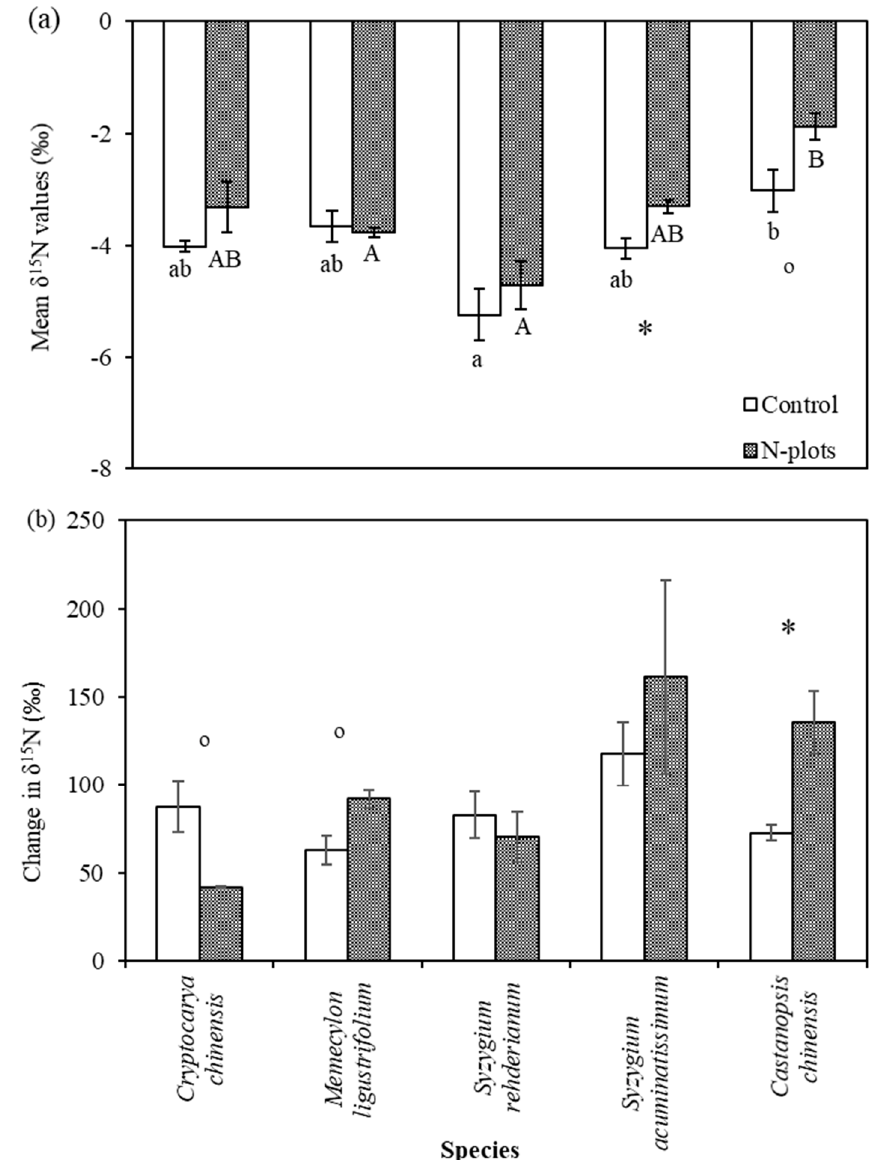
Figure 1. Leaf δ 15 N values of co-occurring dominant tree species in Dinghushan Biosphere Reserve (DHSBR): ( a ) natural δ 15 N abundance in control and N-plots; and ( b ) changes in leaf δ 15 N values after one year of 15 N tracer addition in both treatments. The change in leaf δ 15 N values in ( b ) was determined by subtracting the δ 15 N found prior to the 15 N addition presented in ( a ) from the leaf δ 15 N values obtained after the one-year 15 N tracer addition in each treatment. Error bars indicate SE among plots ( n = 3). In graph ( a ), tree species means with di ff erent letters indicate significant species di ff erences ( p < 0.05) in the control plots (lowercase letters) and in the N-plots (uppercase letters). In graph ( b ), species di ff erences are not significant. In both ( a ) and ( b ), significant e ff ects of N addition on leaf δ 15 N of a given species are indicated by * ( p < 0.05) and o ( p < 0.1).